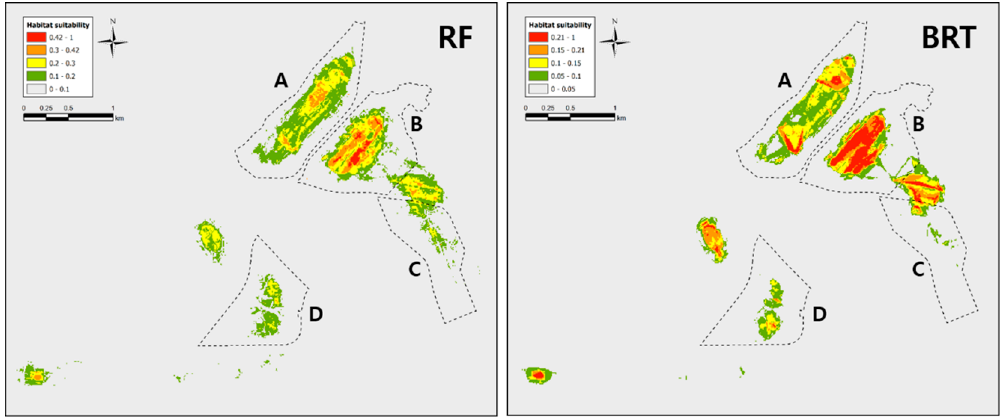
Figure A1. Dryophytes suweonensis SDM results using RF (random forest) and BRT (boosted regression trees). These results follow an applied average suitability approaches to designate a threshold for D. suweonensis habitability suitability. RF and BRT show that site B mainly is suitable to D. suweonensis .